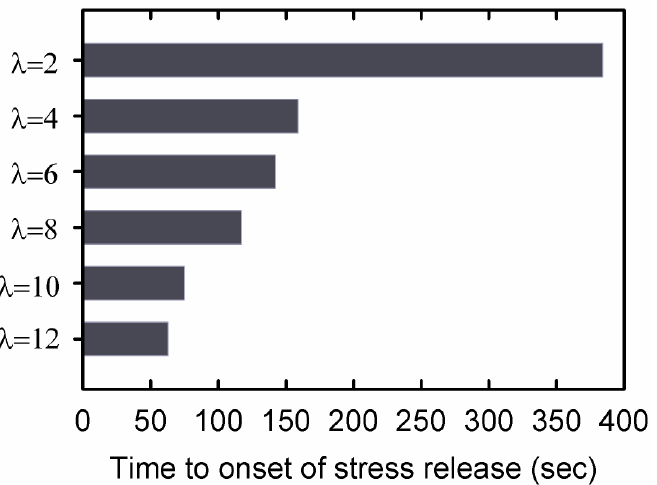
Figure 7. The time to onset of stress release (TOSR) for the dried AMPS(1,2,2,9)/AAm(2,0.1,0.01,97) DN hydrogels with different extension ratios. TOSR was defined as the time it took for the stretched sample to begin bending when immersed in water.